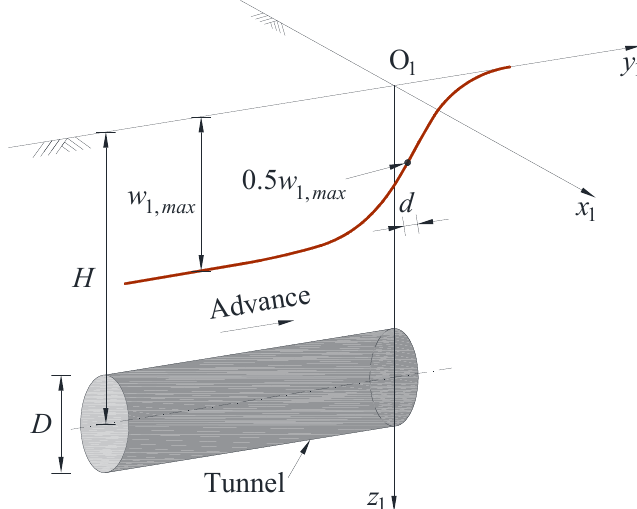
Figure 1. Greenfield surface settlement above a tunnel axis.